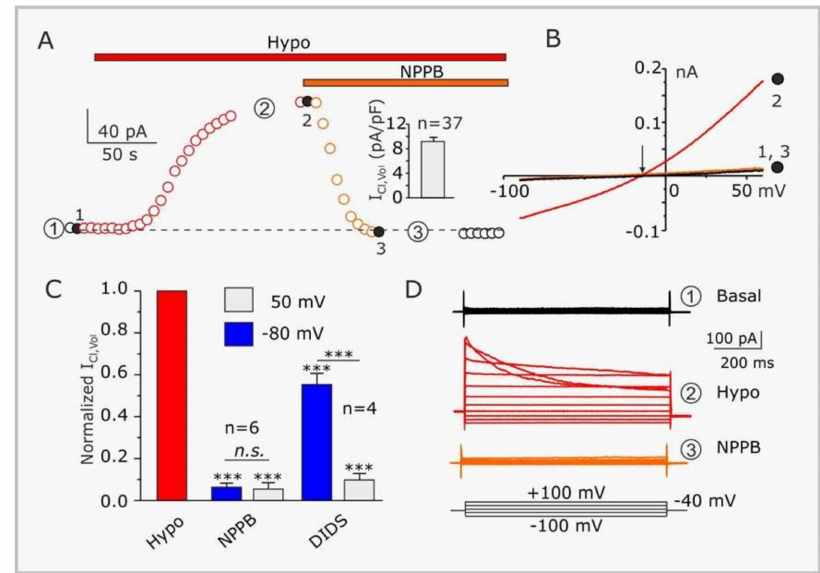
Figure 1. Biophysical and pharmacological properties of the hypotonicity-activated current expressed in GL-15 glioblastoma cells. ( A ) Time course of the current, activated by 30% hypotonic solution (Hypo), and subsequently blocked by NPPB (100 µ M). The plot was constructed from the current ramps of the type shown in panel B). Inset: Bar plot showing the mean density of the NPPB-sensitive current assessed at +50 mV in 37 GL-15 cells. ( B ) Representative current ramps under basal (isotonic) conditions (1), in the presence of a 30% hypotonic solution (2), and in the presence of the hypotonic solution containing 100 µ M NPPB (3). The arrow indicates the reversal potential of the hypotonic-activated current. ( C ) Bar plot showing the effects of 100 µ M NPPB ( n = 6) or 500 µ M DIDS ( n = 4) on the hypotonic-activated current. ( D ) Families of current traces obtained by applying to the same GL-15 cell shown in panels A) and B) 1 s voltage steps from − 100 to +100 mV, in steps of 20 mV, from a holding potential of − 40 mV, under basal conditions (Basal, 1), in the presence of a 30% hypotonic solution (Hypo, 2), and in the presence of a hypotonic solution containing 100 µ M NPPB (NPPB, 3). Modified from Catacuzzeno et al.